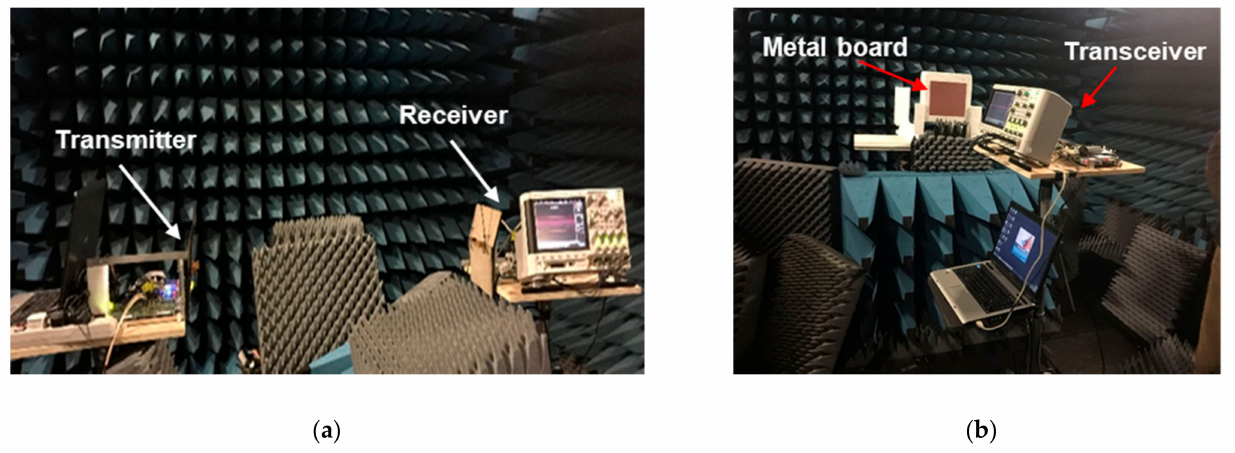
Figure 3. Calibration in the anechoic chamber, ( a ) back-back mode and ( b ) radar